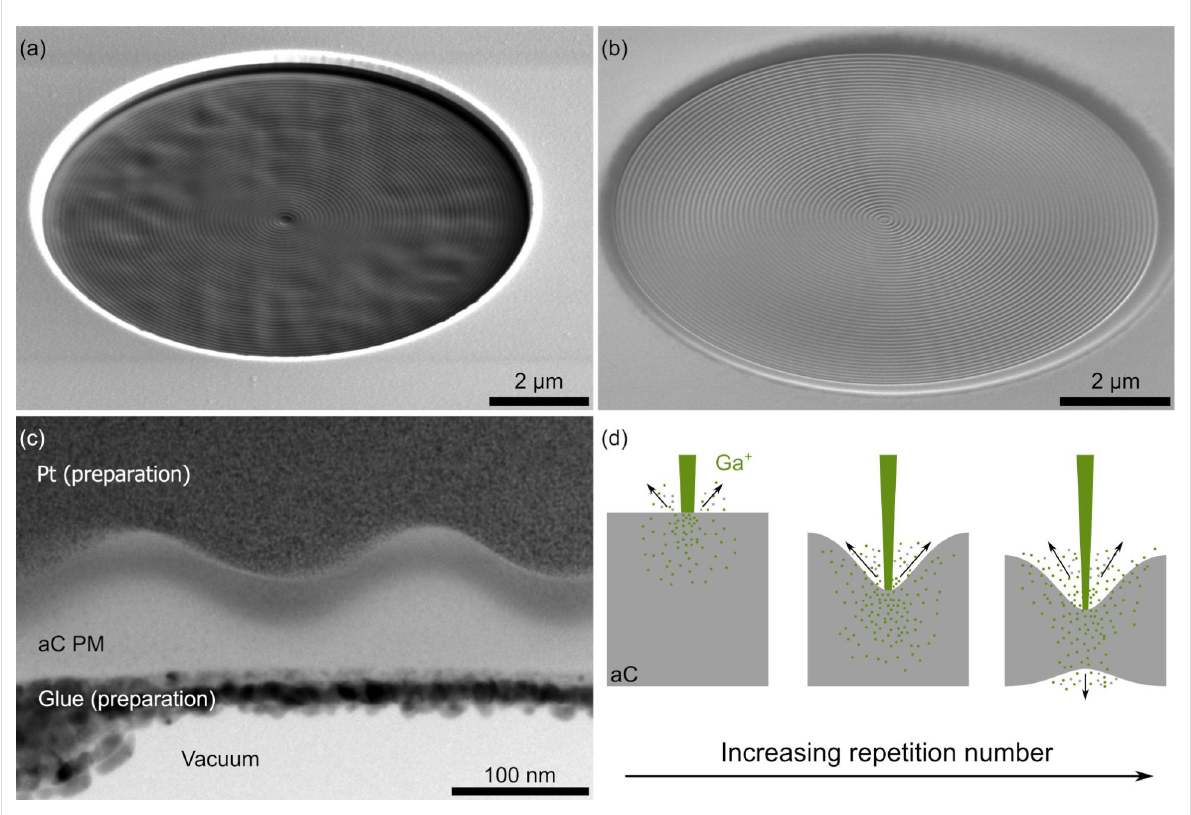
Figure 4: SEM images after structuring the pattern according to Equation 3 with k ρ = 10 µm − 1 for (a) a FIB-prepared and (b) a floated aC thin film. Since the latter is smoother, the sinusoidal structure has a better quality. (c) The generated sinusoidal structure is visible in the bright-field TEM image of a cross-section lamella of a PM with k ρ = 5 µm − 1 . Pt was deposited on top to protect the structure during TEM lamella fabrication. We stabilized the free-standing thin films for the lamella preparation by filling the pyramid-shaped trenches with glue. (d) The scheme presents a possible explanation for fast hole formation towards the end of the pattern milling process. The middle scheme corresponds to the situation shown in